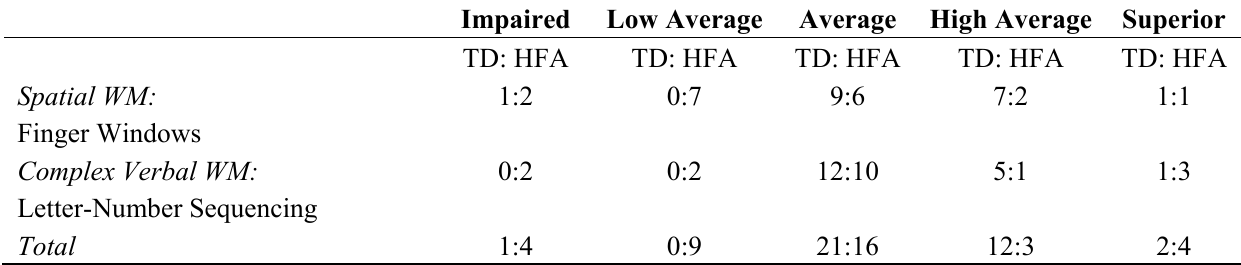
Table 2. Number of individuals in each group per clinical range for working memory tasks.